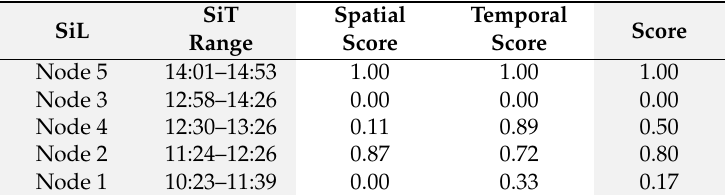
Table 6. Final output of CPSITE simulation for the sample network.